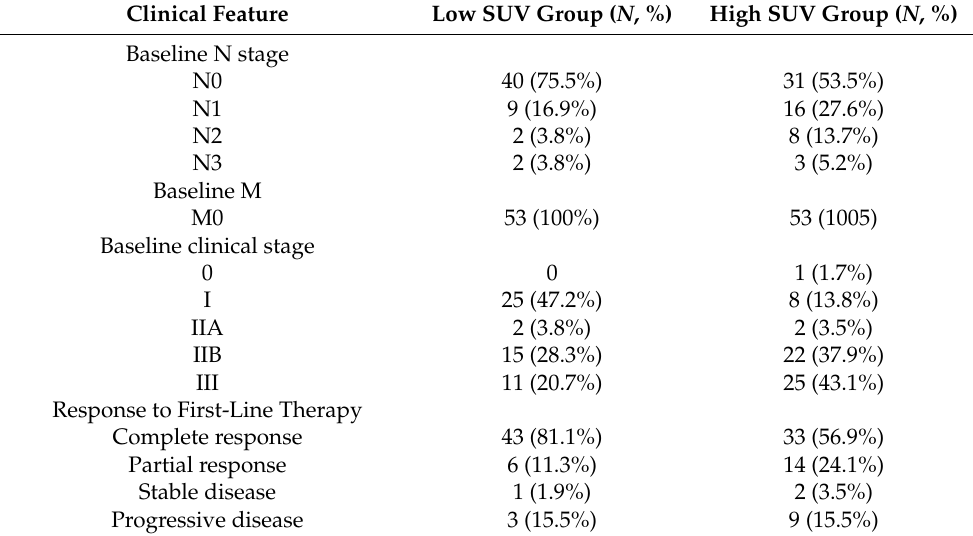
significant (92.5% vs. 81.0%; p = 0.10). The median OS for the entire cohort was 49.5 months (95% CI: 38.5–98.8 months) Figure 3.